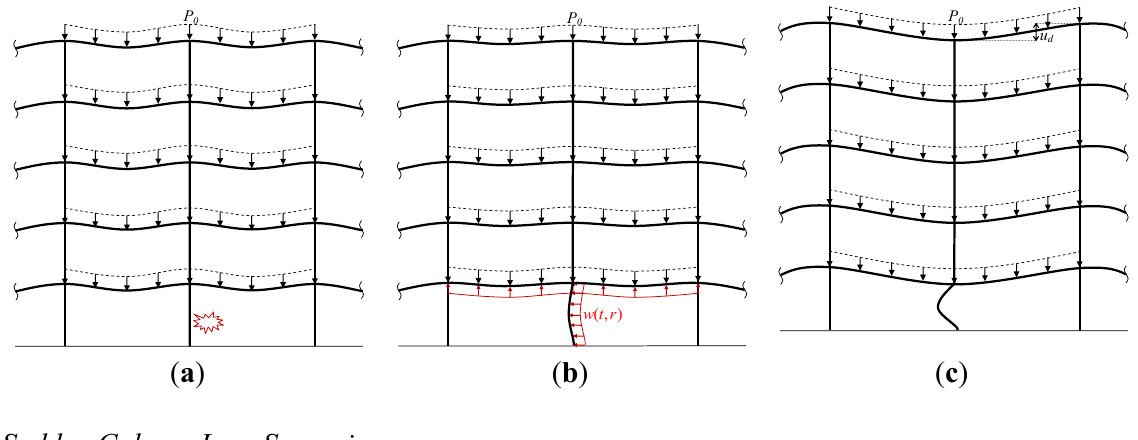
Figure 1. Bay of a multi-story building affected by blast. ( a ) Initial deformed